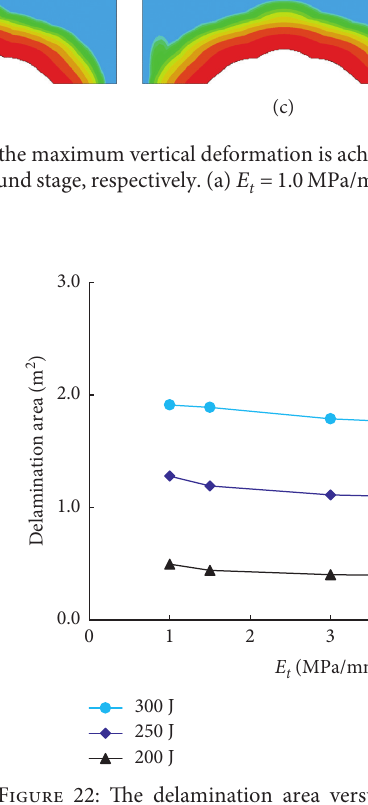
t for various E n under the